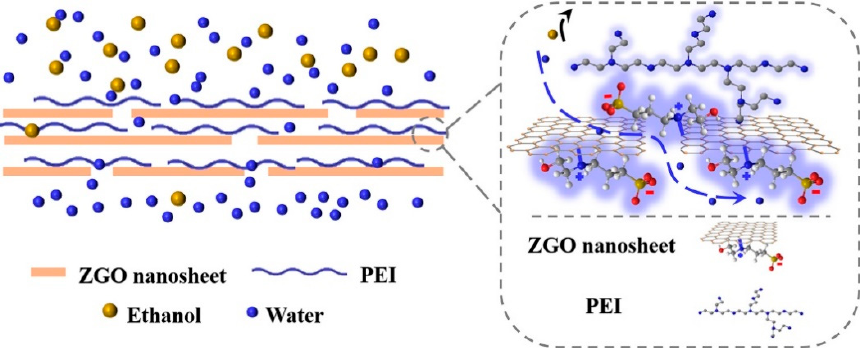
Figure 16. Schematic representation of the water channels present in ZGO-based membranes.